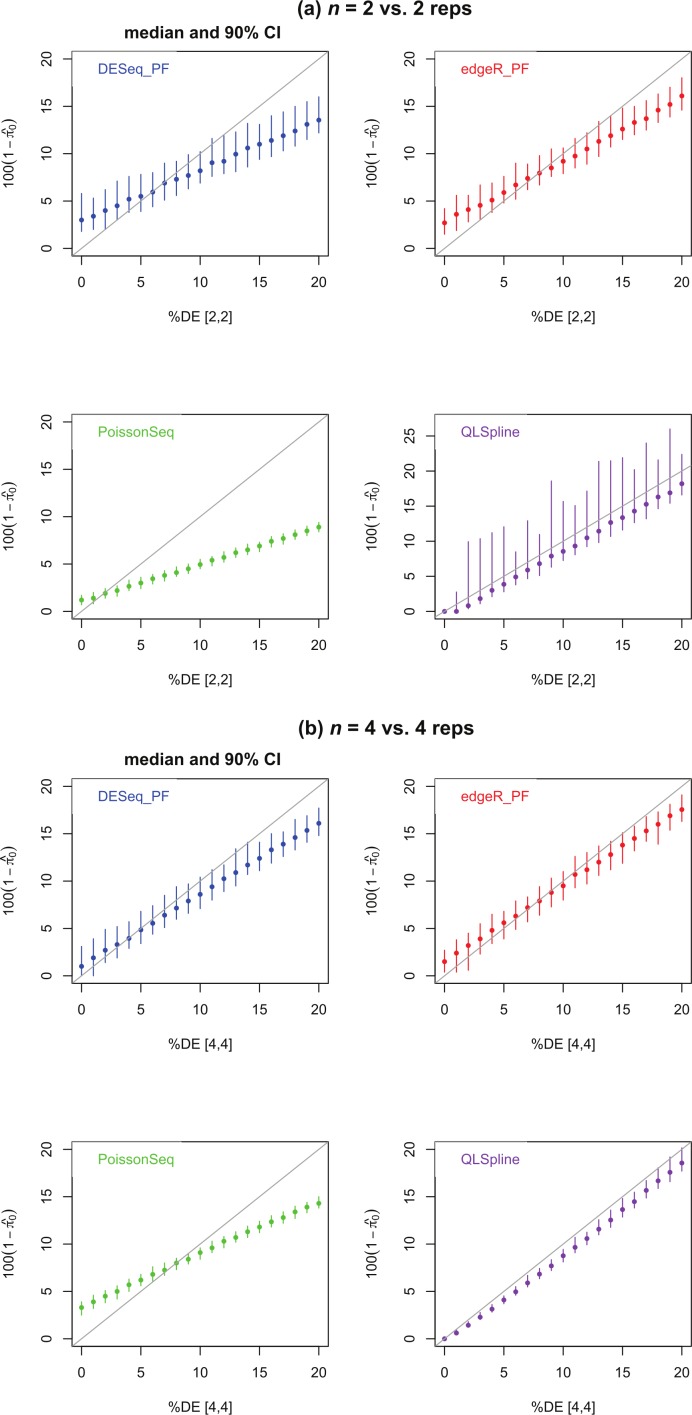
Estimated percentage \documentclass[12pt]{minimal}
\usepackage{amsmath}
\usepackage{wasysym}
\usepackage{amsfonts}
\usepackage{amssymb}
\usepackage{amsbsy}
\usepackage{upgreek}
\usepackage{mathrsfs}
\setlength{\oddsidemargin}{-69pt}
\begin{document}
}{}$100(1-{\hat {\pi }}_{0})$\end{document}1001−πˆ0 of DE genes for synthetic data representing (A) n = 2 replicates and (B) n = 4 replicates of NB data for two different conditions with a specified percentage of genes differentially expressed by at least a factor of 2 in the second condition.Polyfit-DESeq and Polyfit-edgeR are labelled with the extension _ PF. Error bars are 90% confidence intervals and points are medians estimated from 100 independently generated datasets. To facilitate simulation of 100 datasets at each data point without undue computational cost, QLSpline was implemented with the option “Model = Poisson”.